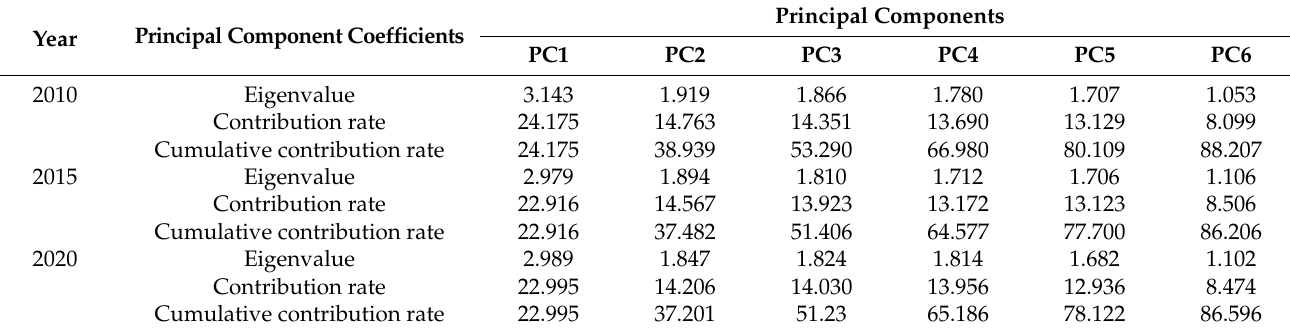
Table 3. Principal component analysis results.